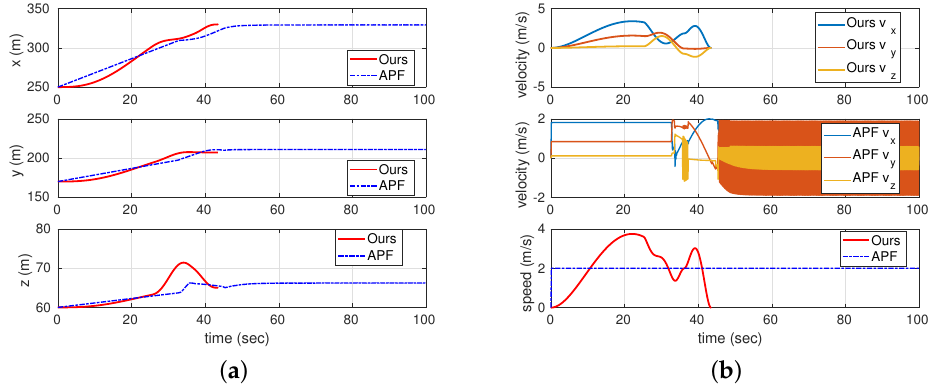
Figure 10. Translation of the GNRON problem case ( a ) Position ( b ) Linear velocity and